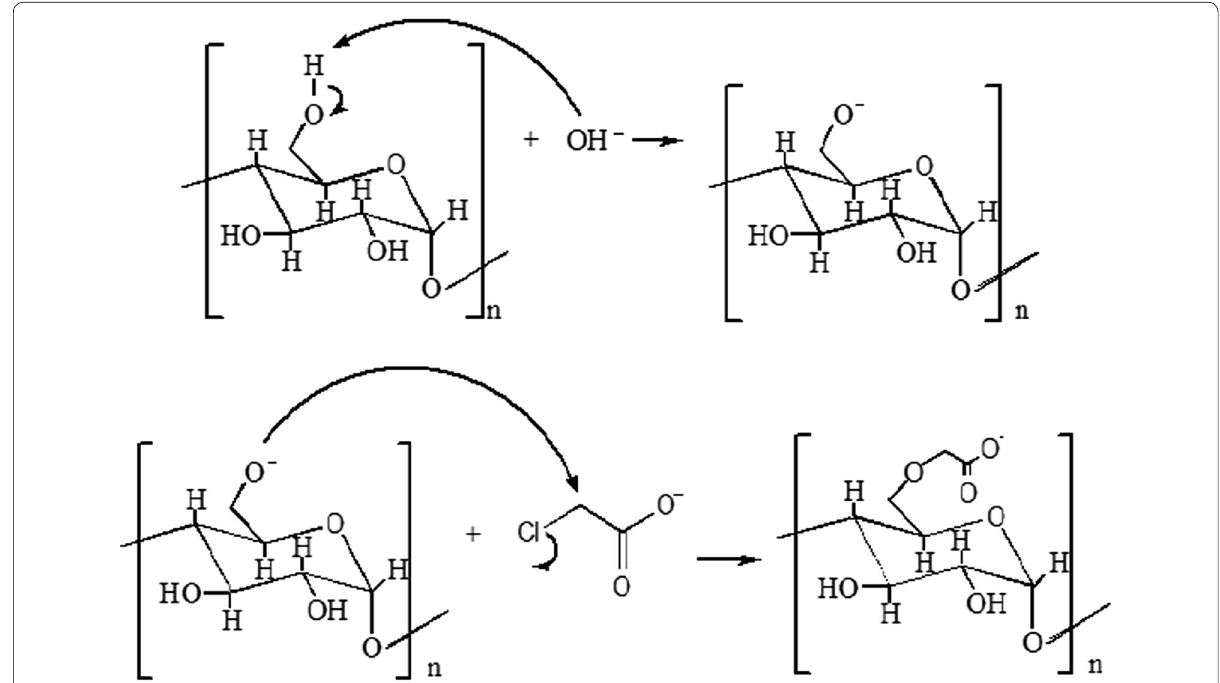
Fig. 1 Schematic diagram of CMSS synthesis via Williamson ether synthesis using NaOH and